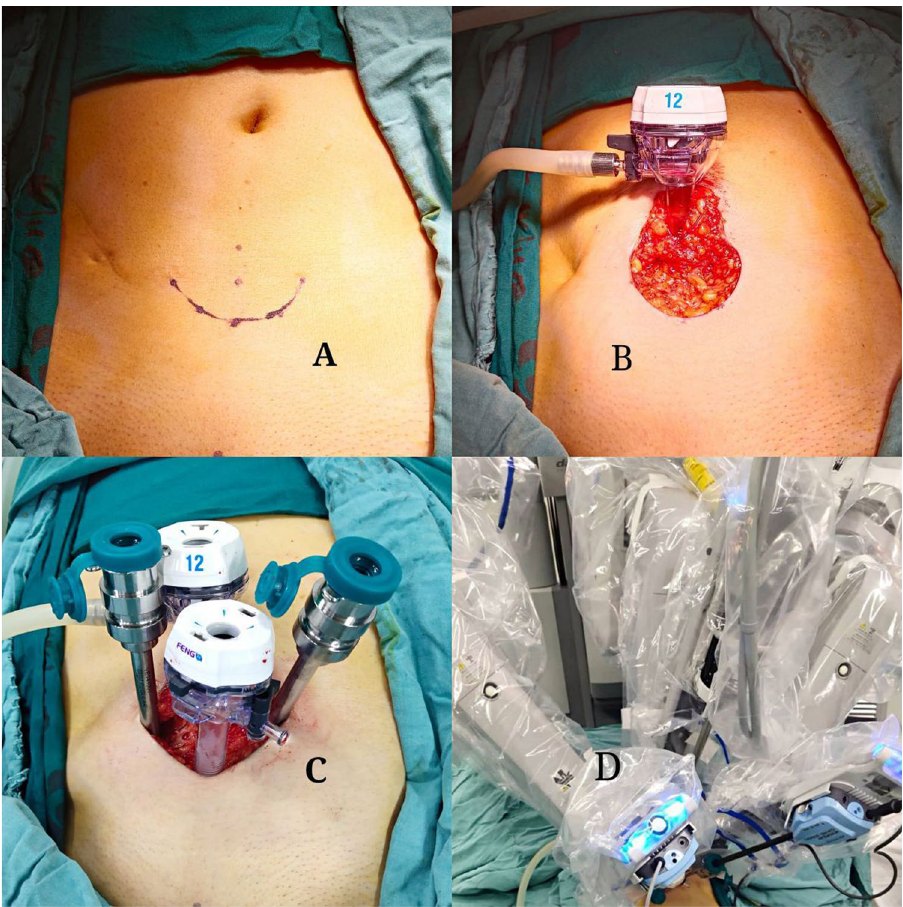
Figure 1. Establishment of a single-incision RARP channel with a modified extraperitoneal technique.